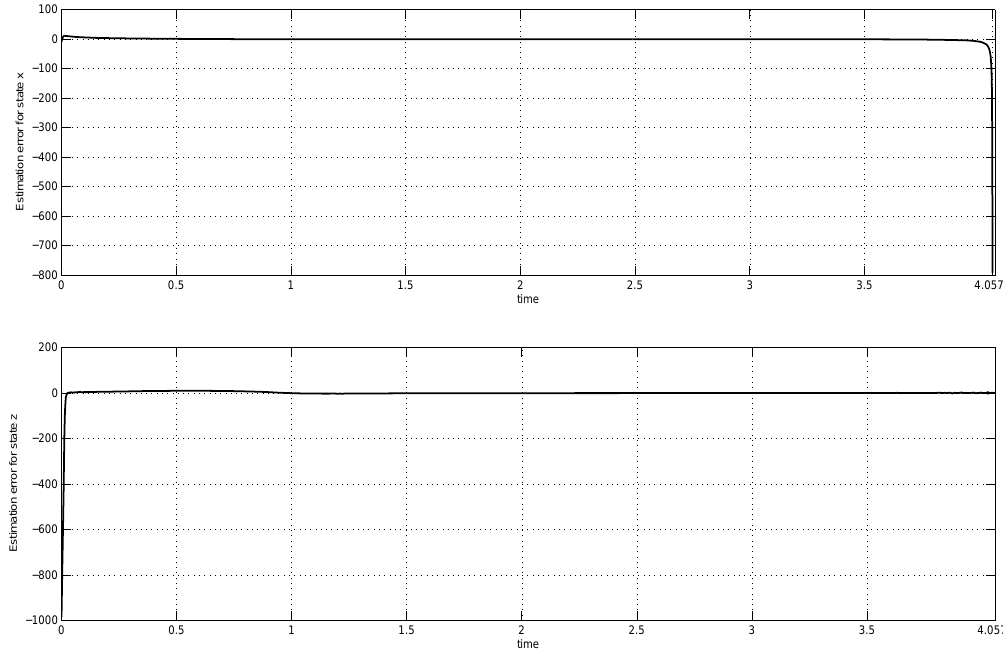
Figure 2: Top. Graph of the estimation error between the reference state x ( t ) (9) and the estimate m G 2 ( t ) (19) in the interval [0 , 4 . 0575]. Bottom. Graph of the estimation error between the reference state z ( t ) (11) and the estimate m G 2 ( t ) (18) in the interval [0 , 4 .